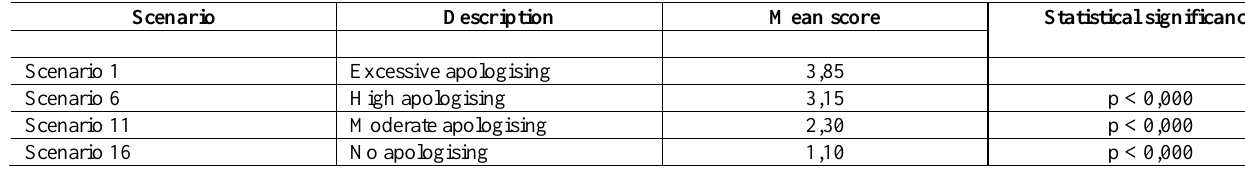
Table 3: Pre-test results apologising: dry cleaning